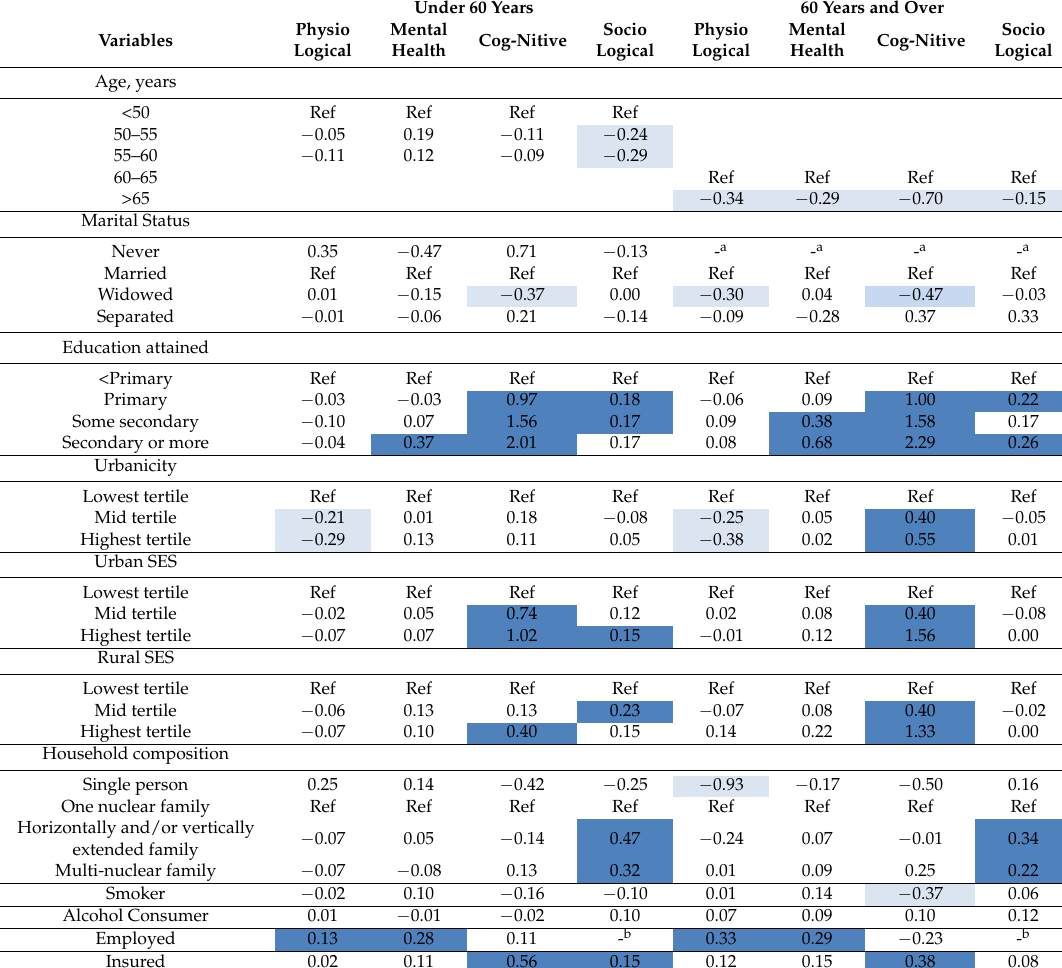
Table 2. Heat map of beta coefficients from age-stratified, univariate associations between sociodemographic and behavioral determinants of SA